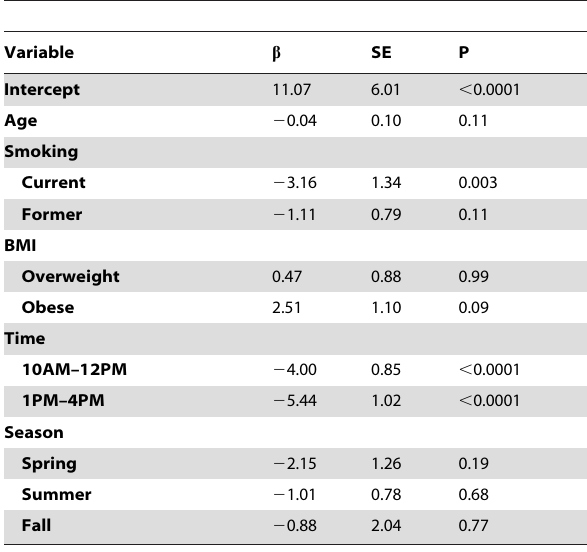
Table 2. Relative impact of environmental and behavioral factors on serum melatonin